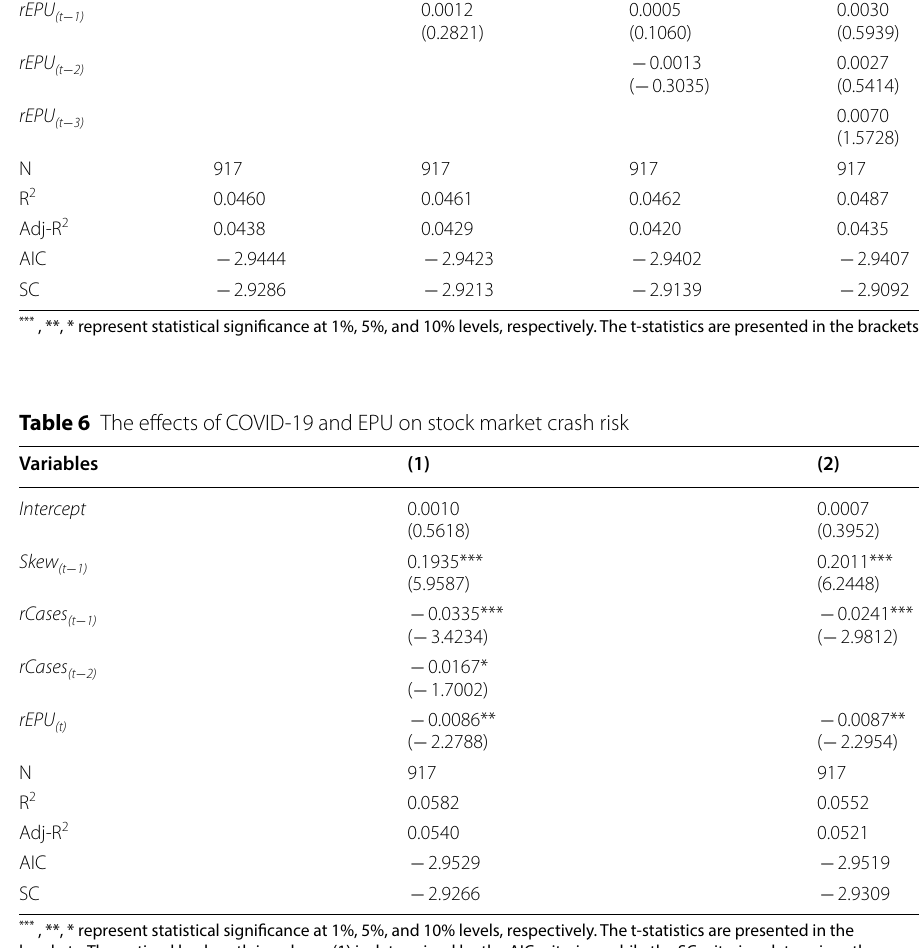
*** , **, * represent statistical significance at 1%, 5%, and 10% levels, respectively. The t‑statistics are presented in the brackets. The optimal lag length in column (1) is determined by the AIC criterion, while the SC criterion determines the optimal lag length in column